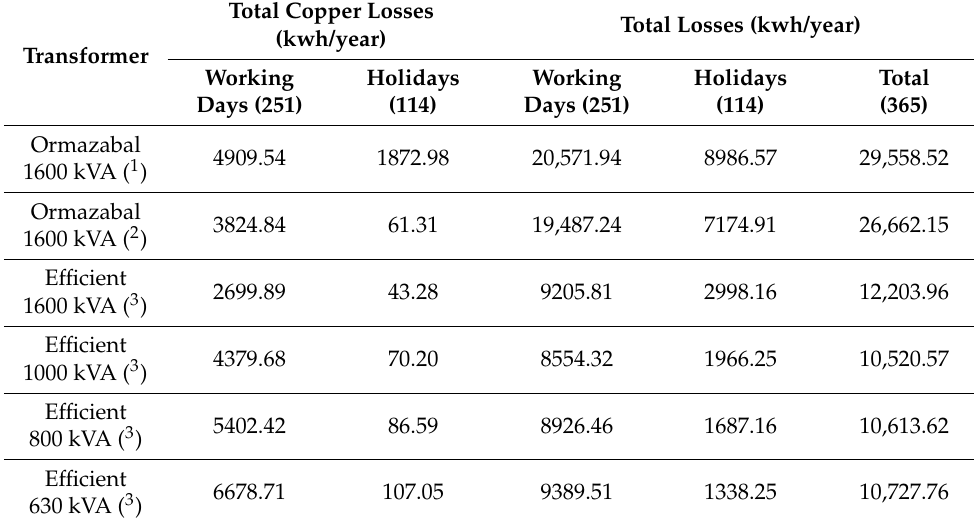
( 1 ) ( 2 ) ( 3 ) c , W c and W c ) and total losses (copper + core losses):